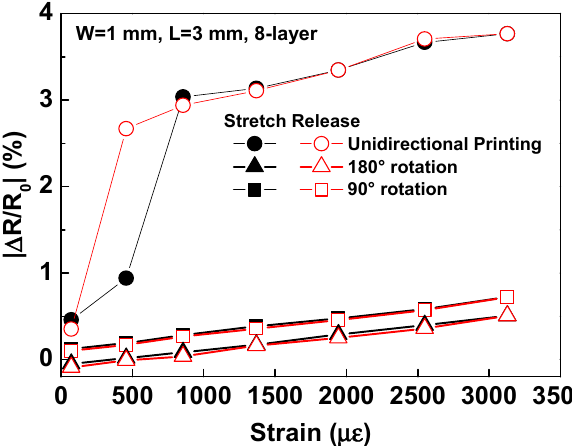
Figure12. Stretch / releasecurvesoftheeight-layerstrainsensorsbyunidirectionalprinting, 180 ◦ rotation, Figure 12. Stretch/release curves of the eight-layer strain sensors by unidirectional printing, 180° and 90 ◦ rotation, and 90° rotation.